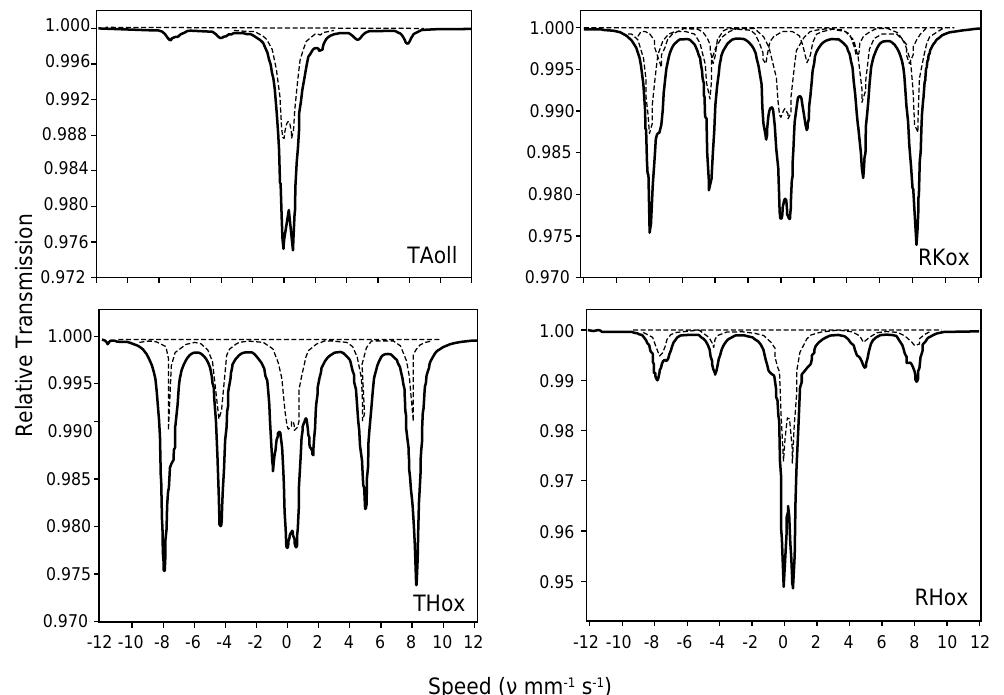
Figure 5. 57 Fe Mössbauer spectra at ~298 K for samples from the diagnostic soil